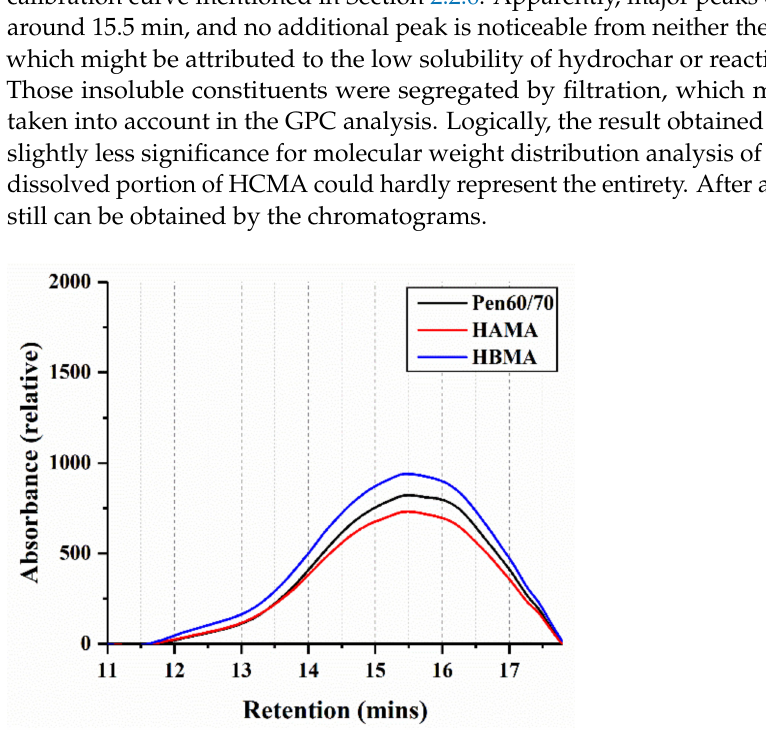
Figure 10. Gel permeation chromatography (GPC) chromatograms of test